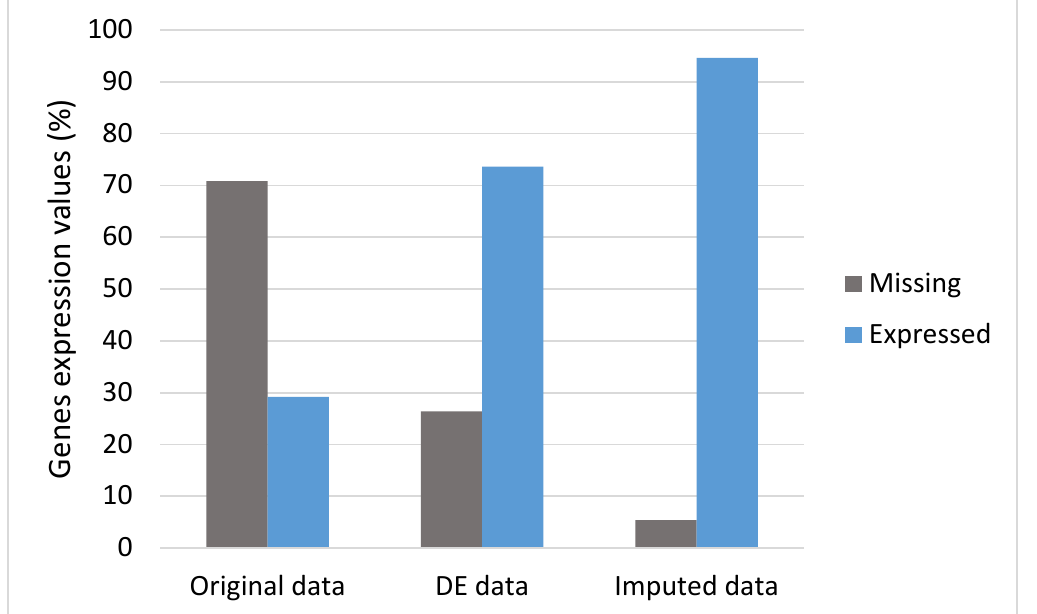
Figure 4. Comparing the data before and after performing imputation.